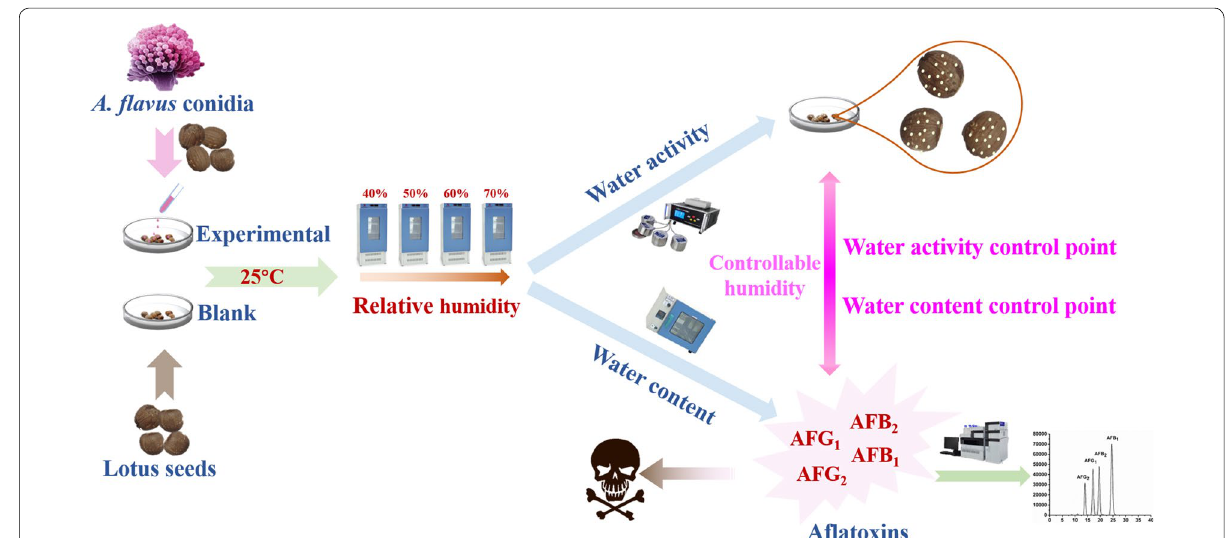
Fig. 1 Schematic diagram on exploration of the correlation between mildew and water content and activity of lotus